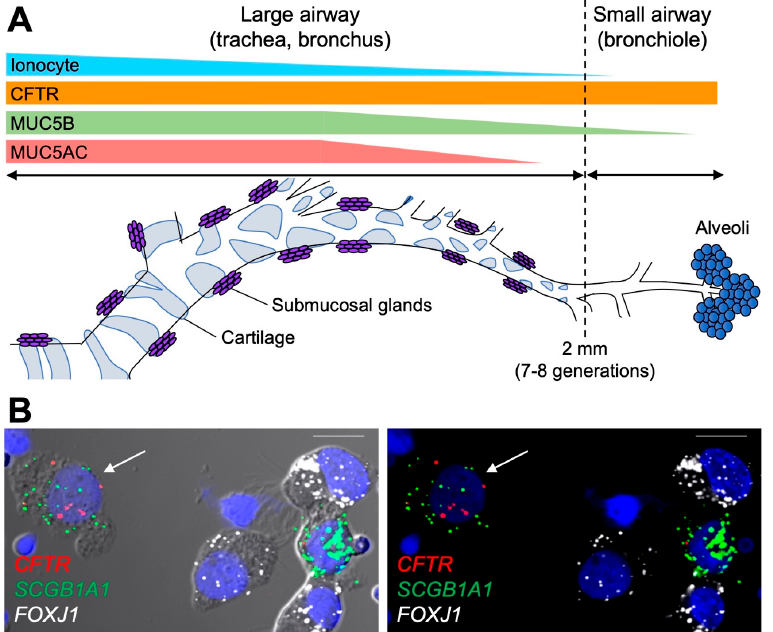
Figure 1. Intraregional expression of secretory mucins and CFTR in human airway superficial epithelia. ( A ) Regional distribution of secretory mucins, ionocytes, and CFTR transcripts in human conducting airway superficial epithelia. In the proximal (large) airways, both MUC5B and MUC5AC are expressed by the superficial epithelium. In the distal (small) airways, MUC5AC expression ceases, while MUC5B expression persists. CFTR is expressed by the superficial epithelium throughout the entire conducting airways, whereas the frequency of ionocytes is reduced in the distal airways. ( B ) RNA in situ hybridization (RNA-ISH) on isolated small airway epithelial cells. Cells were isolated from freshly excised small airway tissue obtained from a non-diseased transplant donor lung. Using RNA-ISH probes, CFTR colocalized with secretory cell marker transcripts ( SCGB1A1 ) in a non-ciliated cell (arrow) and not with FOXJ1 -positive ciliated cells. Left image shows differential interference contrast and fluorescent image overlay. Right image shows fluorescent image only. Scale bar = 10 µ